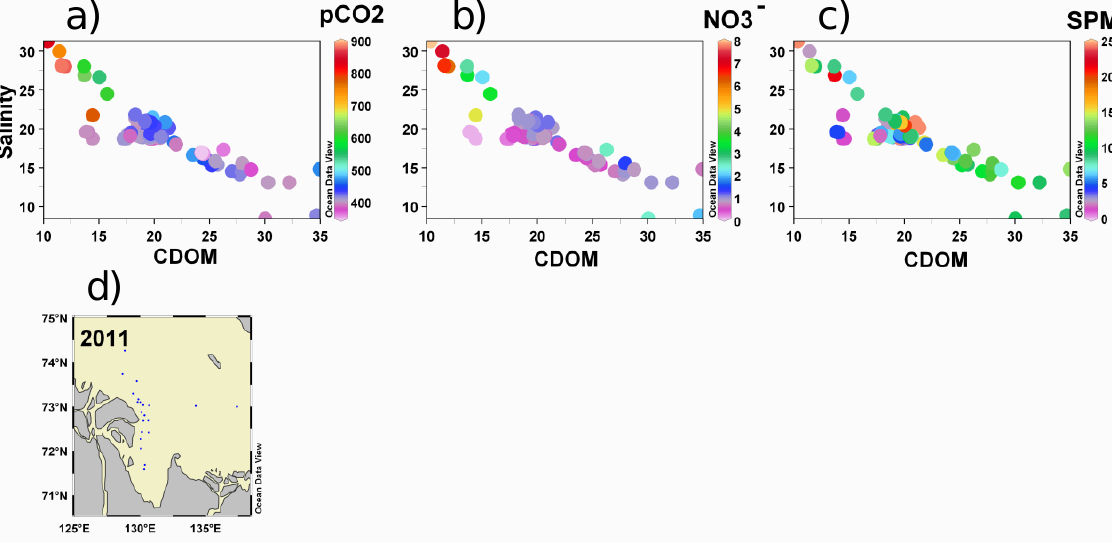
Fig. 10. Plots of CO 2 partial pressure ( p CO 2 , µatm), color-coded by salinity and colored dissolved organic matter (CDOM, mgm − 3 ) (a) ; nitrates (NO − , µM) color-coded by salinity and CDOM (b) ; suspended particular matter (SPM, mgL − 1 ) color-coded by salinity and CDOM 3 (c) . Position of transect performed in 2011 is shown in (d)